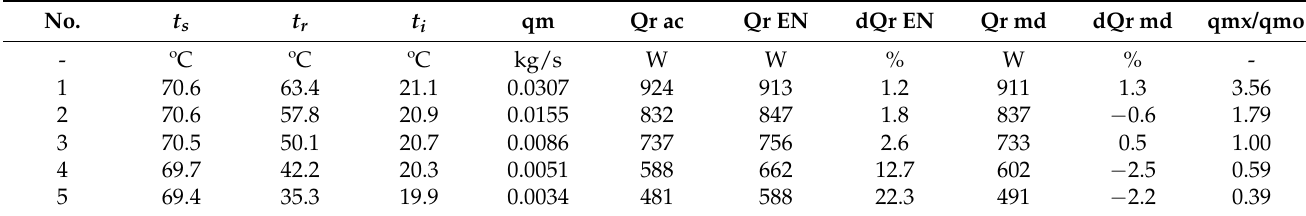
Table 1. The comparison between the measurement and the calculations results Radiator T1. t s = 70.0 ◦ C.